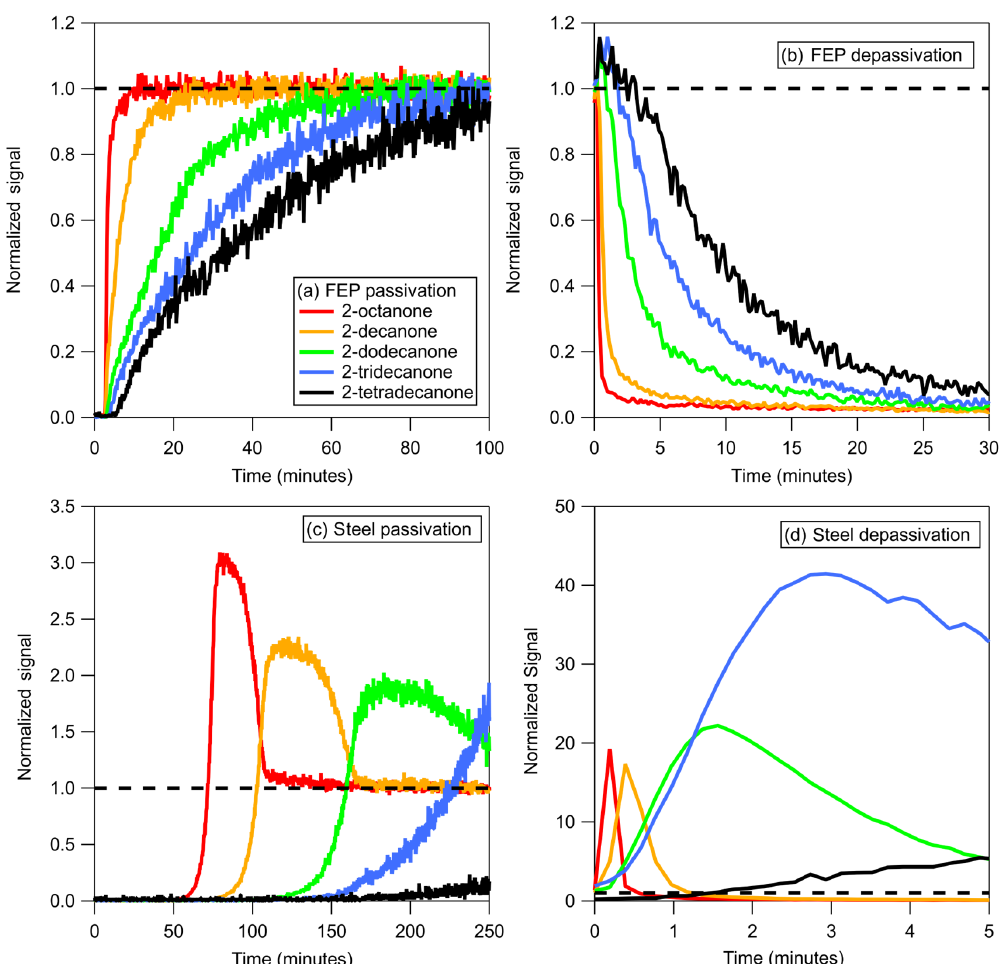
Figure 1. (a) Passivation and (b) depassivation curves measured for step function changes in a series of 2-ketones sampled through absorbent tubing (3m of FEP Teflon). (c) Passivation and (d) depassivation curves measured for step function changes in a series of 2-ketones sampled through adsorbent tubing (1m of stainless steel). Absorbent and adsorbent tubing was depassivated using dry and 40% RH air, respectively. Note the different scales in panels (c) and (d) . Signals were normalized to the values measured when sampling directly from the chamber, which were given a value of 1.0 and are represented by the dashed line in the figure.